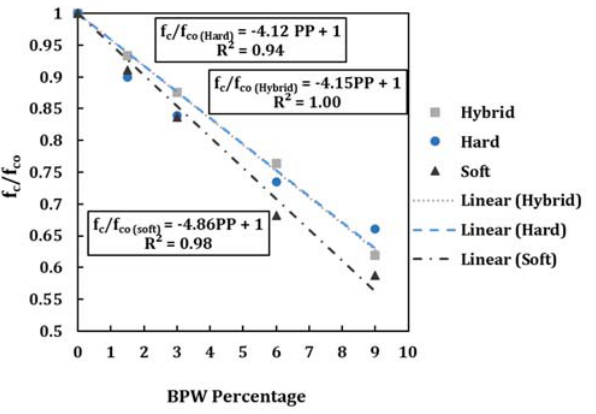
Figure 6. The compressive strength ratio of BPW-containing concrete to control concrete versus BPW percentages.